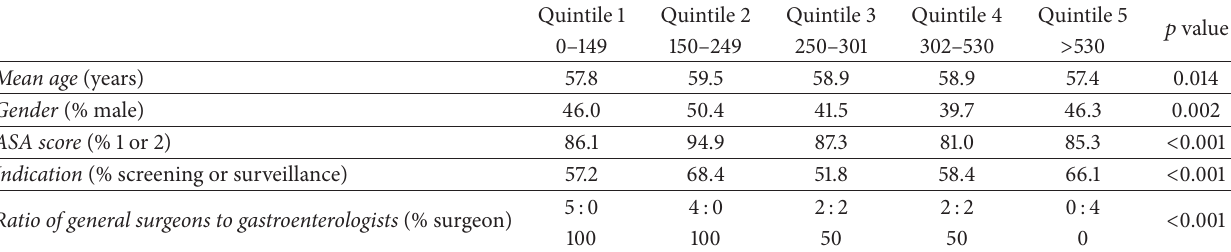
Table 1: Distribution of potential confounding variables within the five endoscopist annual colonoscopy volume quintiles.